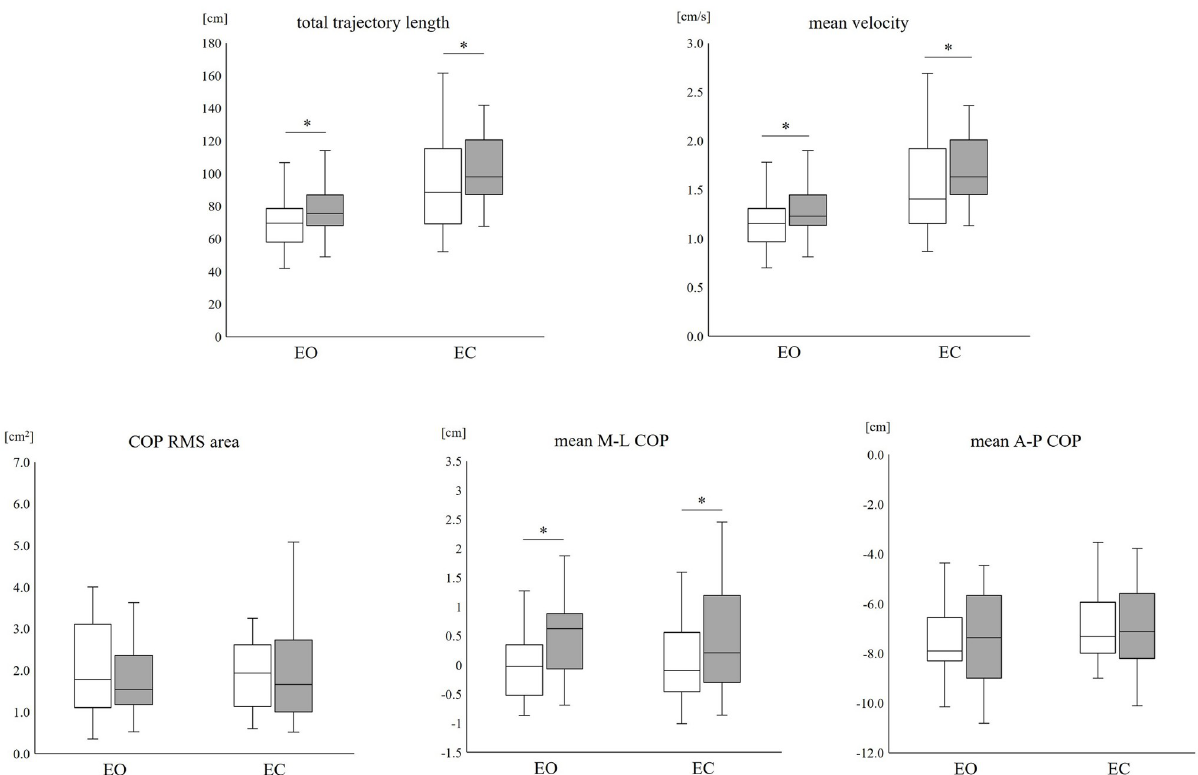
Fig 2. Changes in postural sway during quiet standing after 10 h lower limb immobilization. White: Before, Gray: After 10 h. � p < 0.05. A-P: Anterior-posterior, COP: Center of pressure, EO: Eyes-open condition, EC: Eyes-closed condition, M-L: Medial-lateral, RMS: Root mean square.